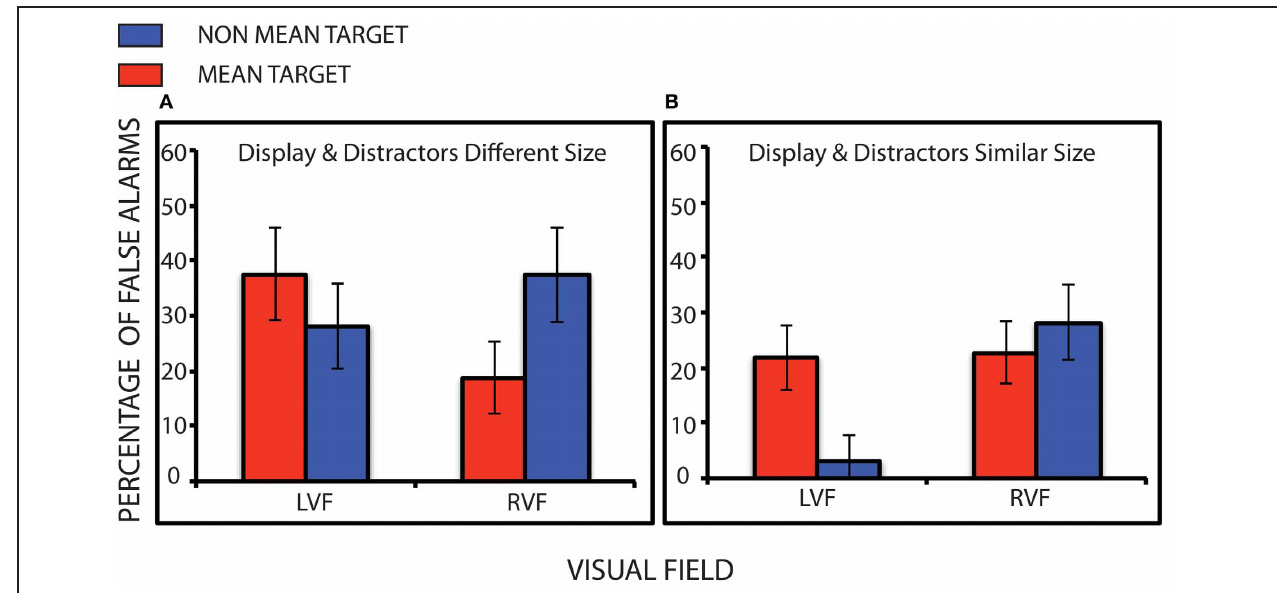
the mean and non-mean on the right side are large (and mirror the original findings), suggesting that distractors are influencing statistical coding. Whereas, in panel (B) , there is minimal difference between the mean and non-mean targets on the right side, suggesting that distractors are minimally impacting statistical